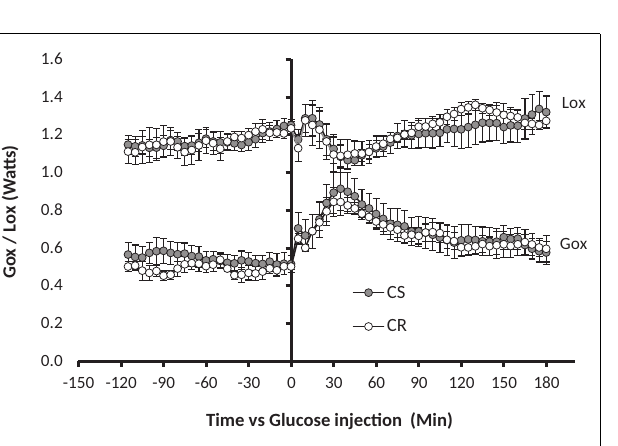
FIGURE 3 | Changes in blood glucose and plasma insulin induced by the GTT (A), MTT (B) and ITT (C) . Open symbols, CR rats; black symbols, CS rats; AUC, area under curve. Blood glucose during GTT: P = 0.02,